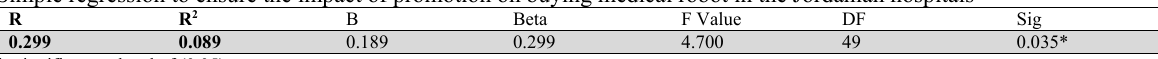
From Table 5 it is observed that there is significant impact of marketing network on buying medical robot in the Jordanian